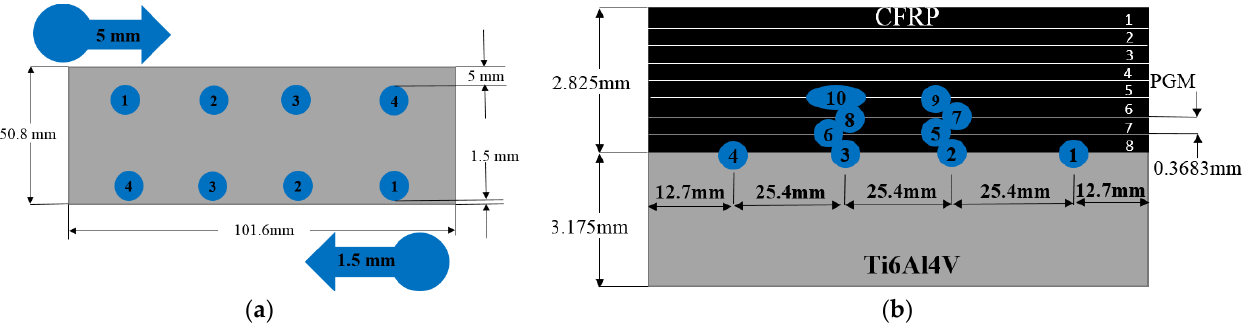
Figure 1. Location of thermocouples within the [0] 8 /Ti6Al4V stack: ( a ) top view of Ti6Al4V plaque thermocouple distribu- tion; ( b ) front view of the [0] 8 /Ti6Al4V stack thermocouple distribution.